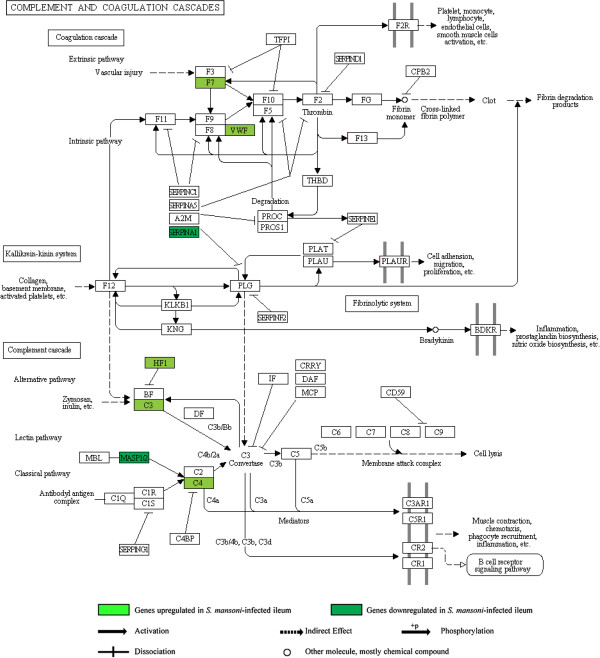
Illustration of the KEGG complement and coagulation cascades pathway with location of 10 associated genes that were differentially expressed in theS. mansoni -infected ileum.